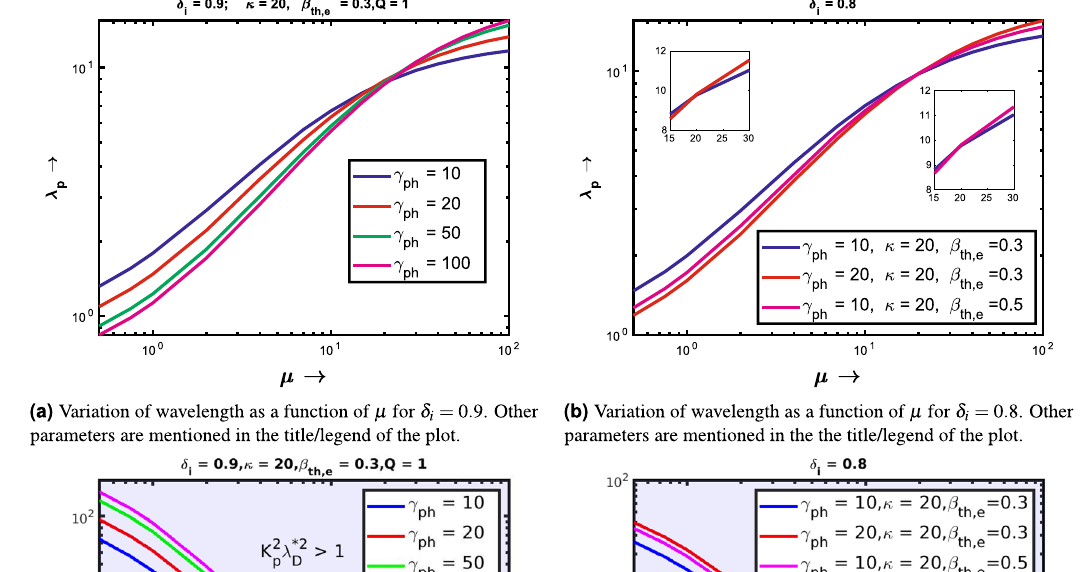
Figure 7. Variation of wavelength ( (cid:31) P ) and ossociated k 2 p (cid:31) ⋆ electronegative plasma with the negative to positive ion mass ratio and Lorentz